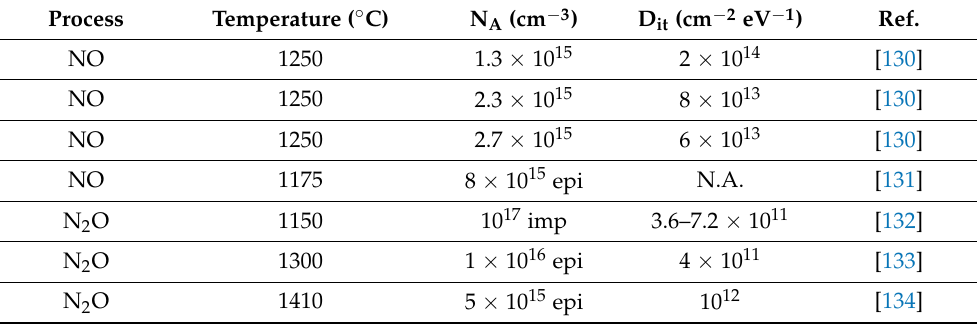
Table 2. Summary of p-type doping concentration and interface state density (Dit) data of gate oxide in 4H-SiC